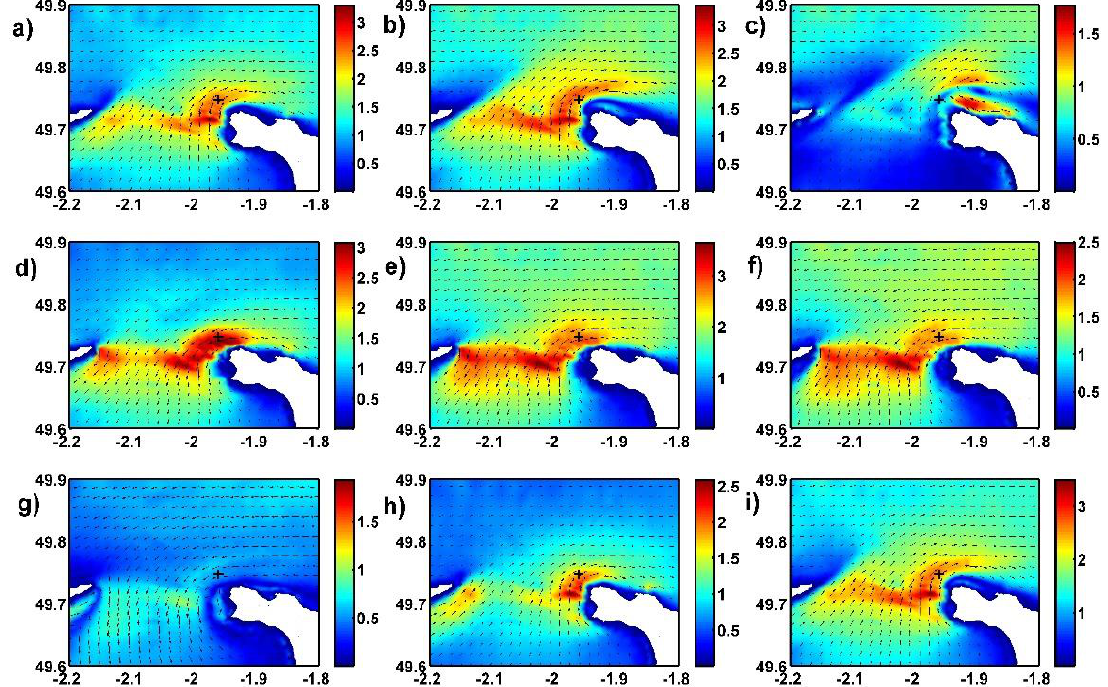
Figure 4. Currents in the Raz Blanchard during a mean tidal cycle. The first and the last plots correspond to high tide. The cross represents the study site.